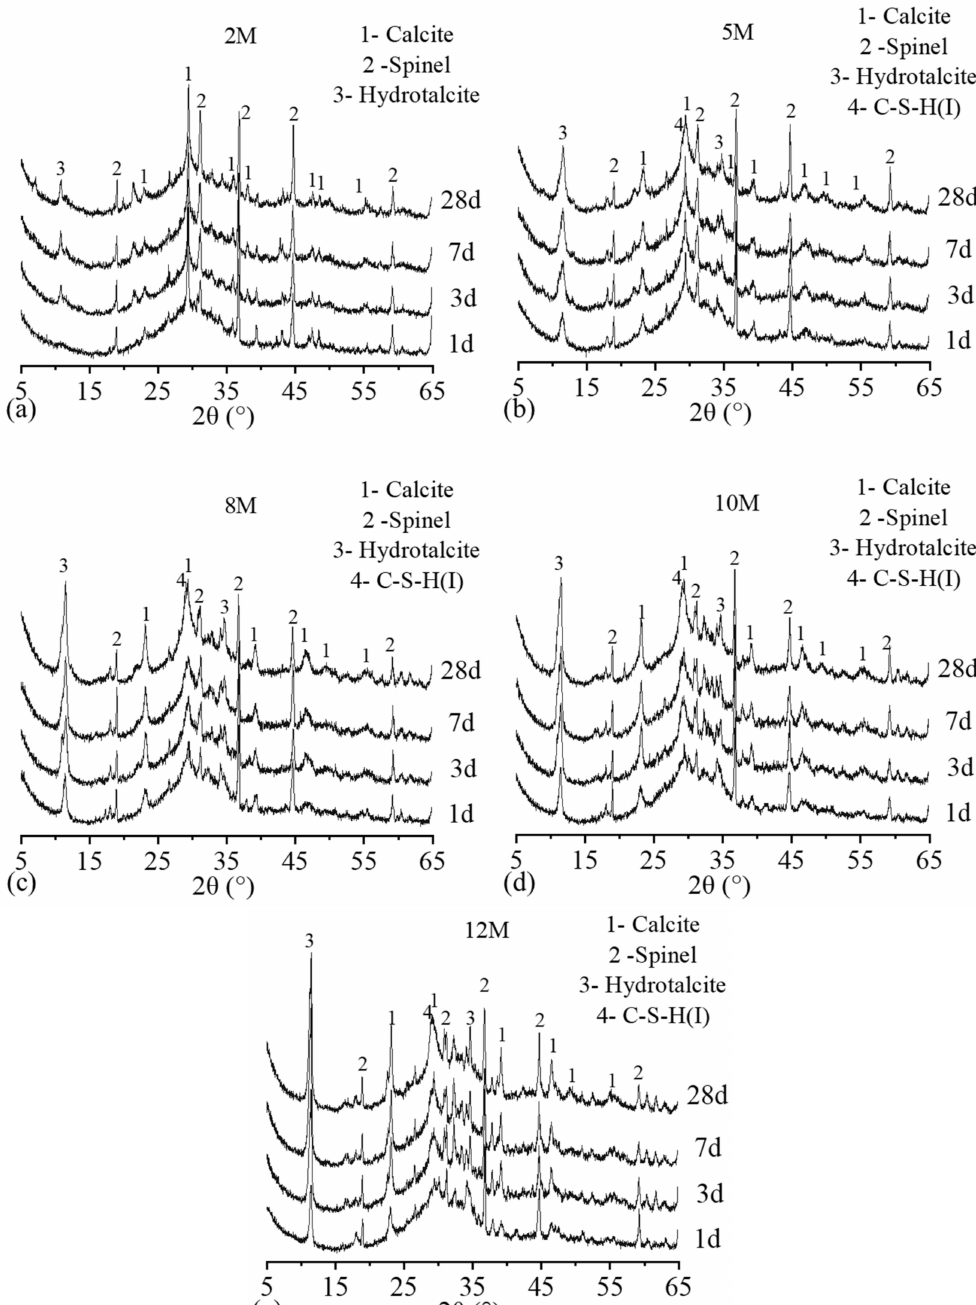
Figure 4. XRD spectra of hardened pastes at different ages: ( a ) 2 M, ( b ) 5 M. ( c ) 8 M. ( d ) 10 M and ( e ) 12